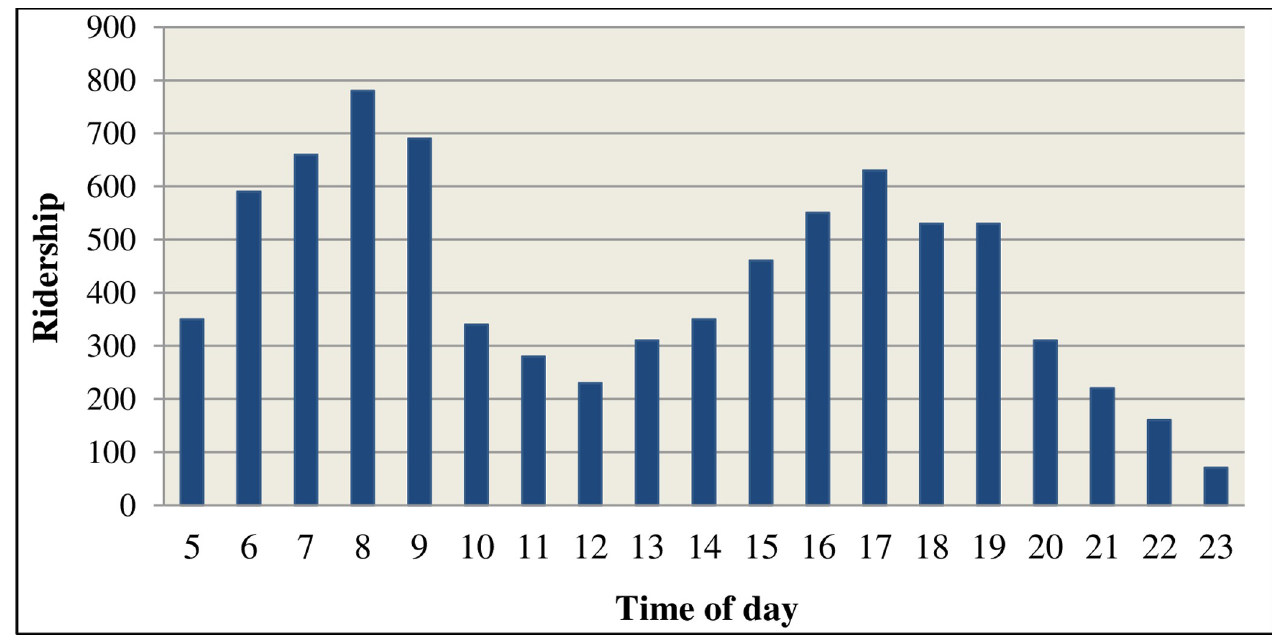
Fig 3. Route U32 average ridership by time of